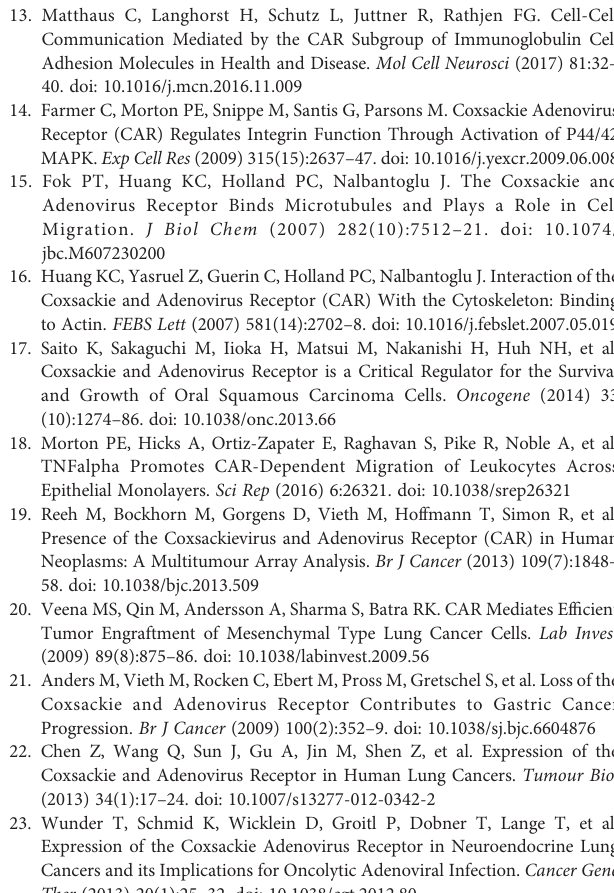
Supplementary Figure 1 | – Manipulation of CAR does not alter key EMT markers (A) Representative confocal images of speci fi ed cell lines fi xed and stained for E-Cadherin (shown as single channel black and white, magenta in merged image) and DAPI (blue). GFP is shown in green in merged channel. Scale bars are 10 m m. (B) Quanti fi cation of E-cadherin intensity from line scans perpendicular to junctionsin all celllines from imagesas in (A) . Data from at least30 junctionsper cell line, representative of 3 independent experiments. (C) Western blots of lysates from indicated cell lines probed for E-cadherin, b -catenin and HSC70. Values shown beneath graph are from densitometry analysis of E-Cadherin blots normalised to parental cellsfrom4 independent experiments +/-SEM. (D) Westernblotsoflysates from indicated CMT cells probed for vimentin and HSC70. Representative of 4 independent experiments. (E) Representative confocal images of FRAP analysis of WTCAR-GFP vs AACAR-GFP over time. (F) Graph shows recovery curves of fl uorescence intensity for each cell line from data as in (E) . Data is from at least 15 differentROIsper cellline,shownasmean+/-SEM,representative of3independent experiments. P values ***p < 0.0005, ****p <